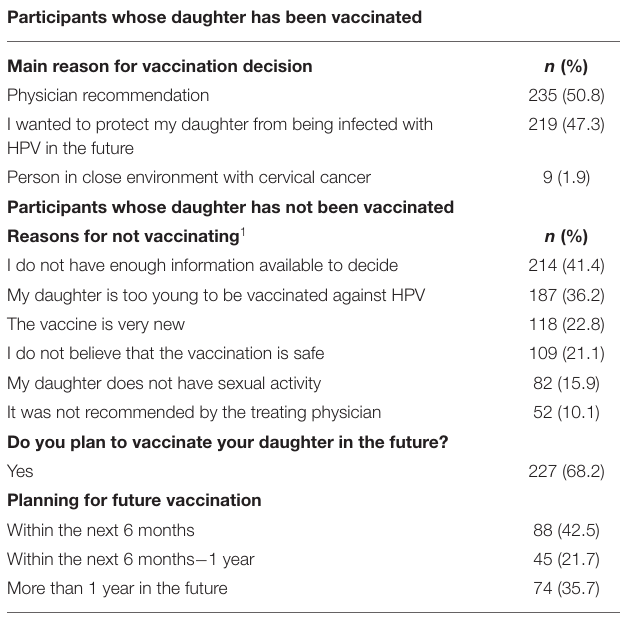
TABLE 2 | Reasons for daughter’s vaccination status. TABLE 3 | Parents’ knowledge and sources of information about the HPV virus, and univariate associations with vaccination coverage of their daughter aged 11–18 years (incl. Risk Ratio and 95%